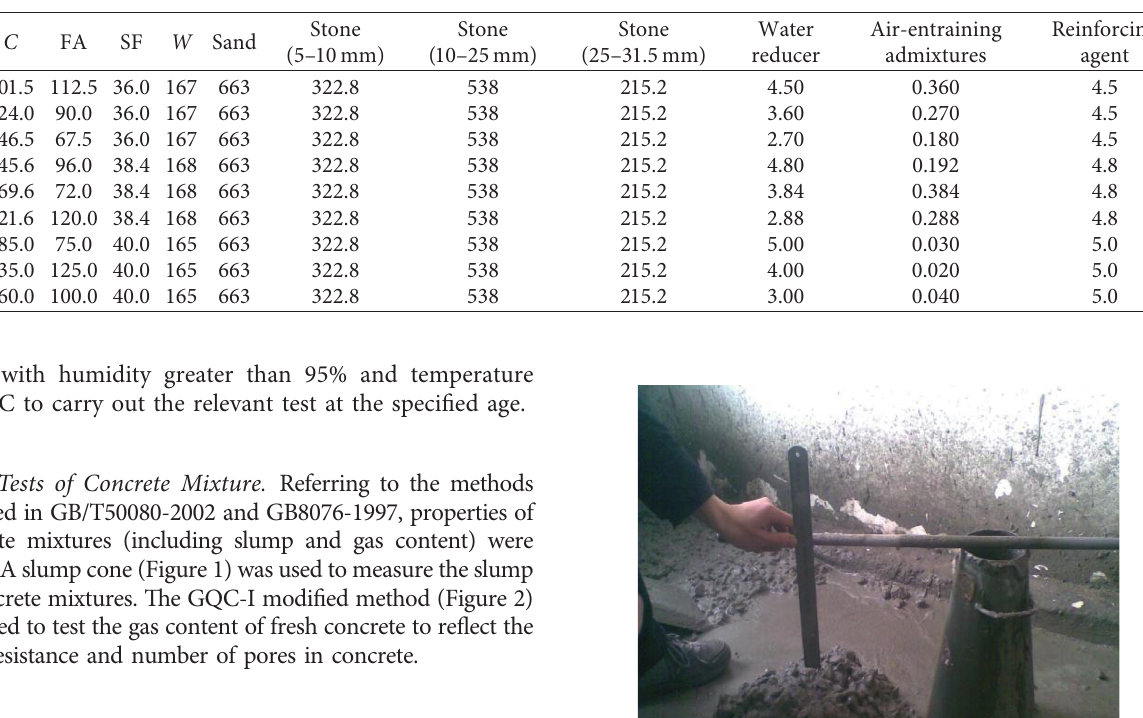
Table 5: Orthogonal design for the optimal mix proportion (kg/m 3 ).